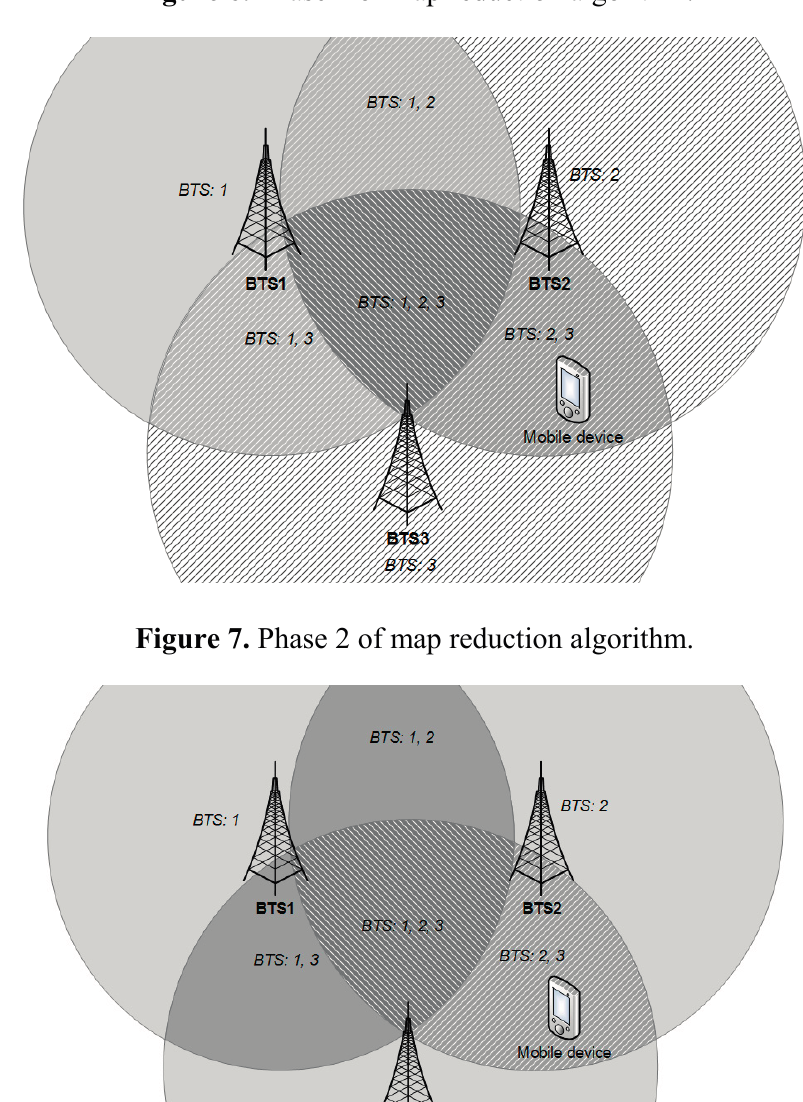
Figure 6. Phase 1 of map reduction algorithm.